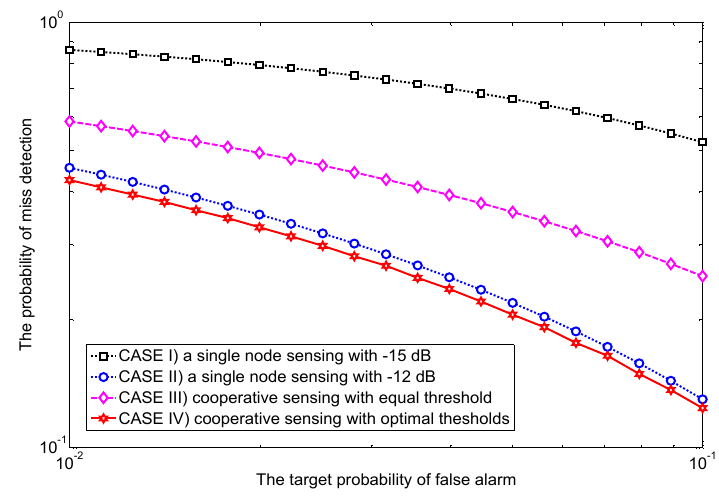
Figure 2. Receiver operating characteristic (ROC) curves of cooperative sensing with two sensing nodes; node 1 with − 15 dB average signal-to-noise ratio (SNR) and node 2 with − 12 dB SNR.